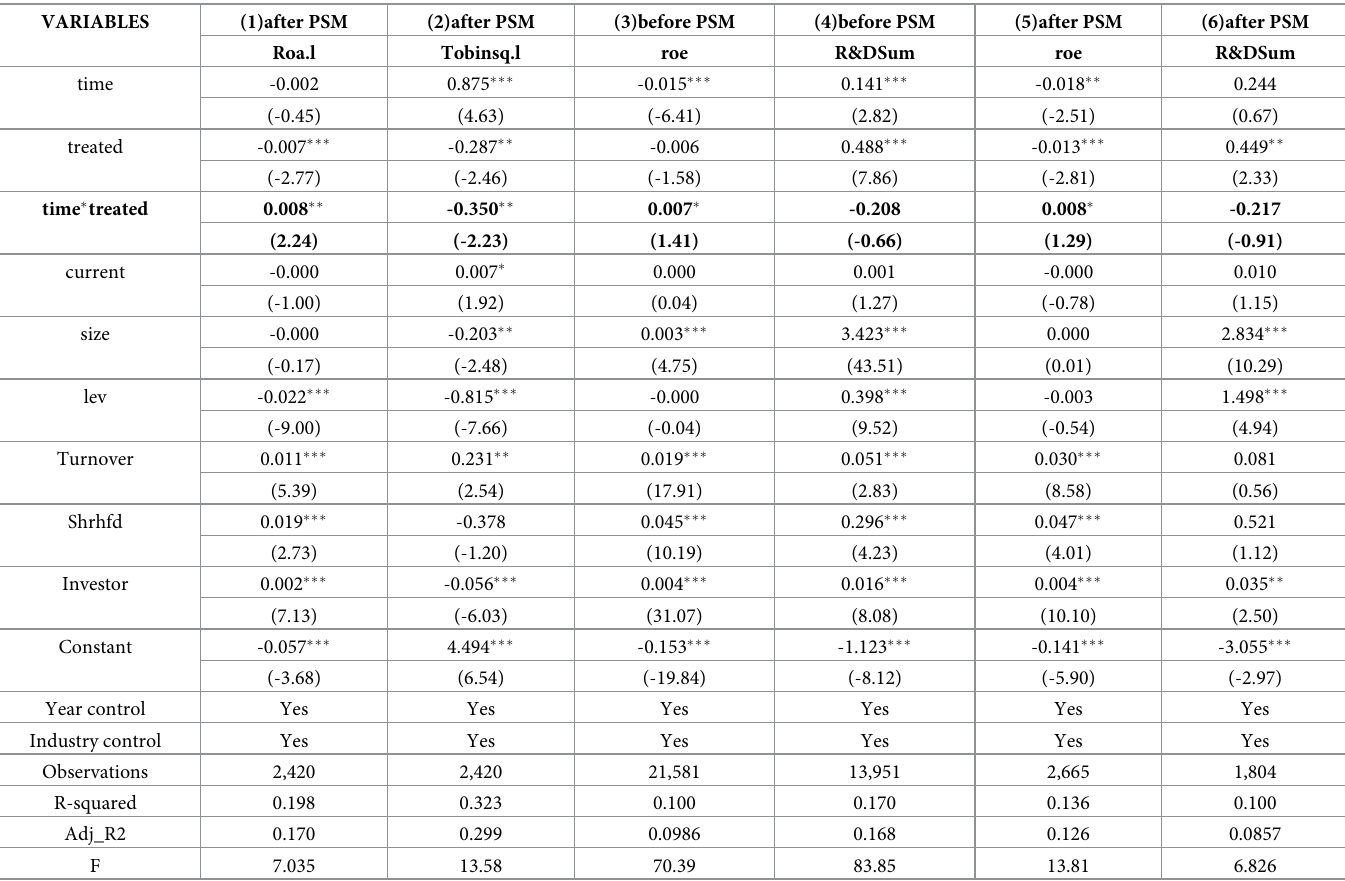
Table 8. Robustness test